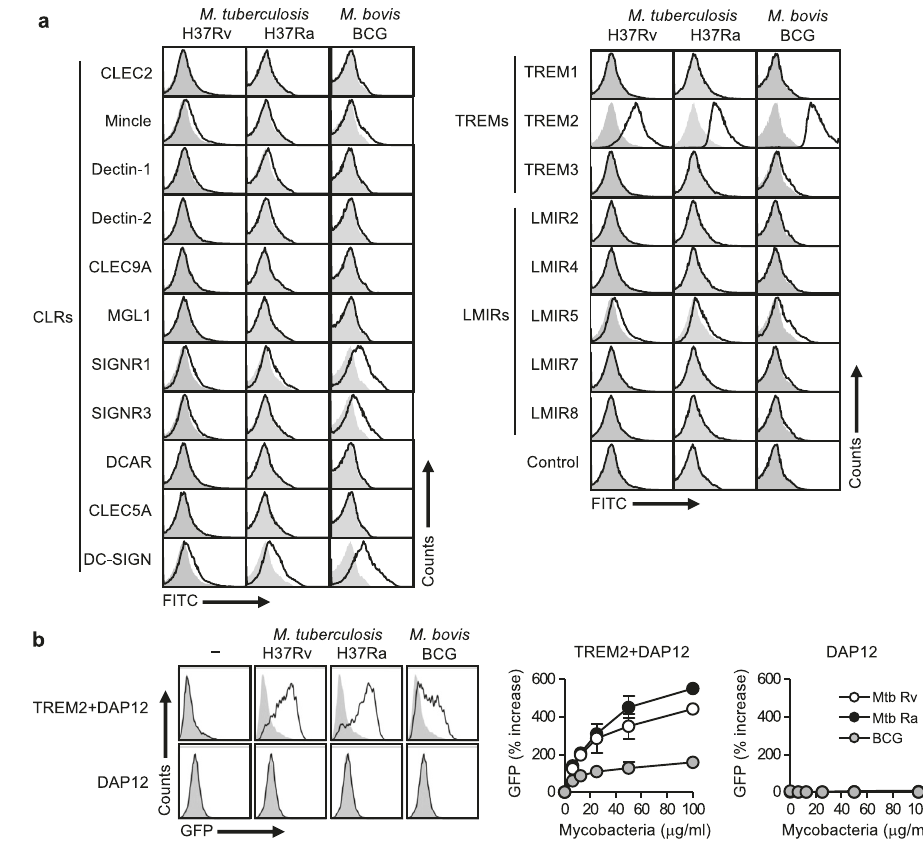
Fig. 1 TREM2 recognizes mantihumanycobacteria. a Heat-killed Mtb H37Ra or H37Rv, or M. bovis BCG were incubated with the indicated CLR, TREM, and LMIR family receptors fused to the Fc-antibody fragment or with the control Fc fragment, followed by staining with antihuman IgG-FITC secondary antibody. The binding of each receptor-Fc protein was analyzed by fl ow cytometry. Open histograms show binding data for the indicated receptor-Fc proteins. The gray- fi lled histograms show background fl uorescence of the control staining. b NFAT-GFP reporter cells expressing TREM2 + DAP12 or DAP12 alone were stimulated with the indicated amounts of heat-killed Mtb H37Ra or H37Rv, or M. bovis BCG for 24 h, followed by analysis of GFP fl uorescence by fl ow cytometry. The histograms on the left indicate the data from stimulation with 100 μ g/ml of the indicated mycobacteria. Data in the right panels are presented as percent increase over control values of unstimulated cells. Data are presented as the mean ± SEM of duplicate assays and representative of three independent experiments. Source data are provided as a Source data fi